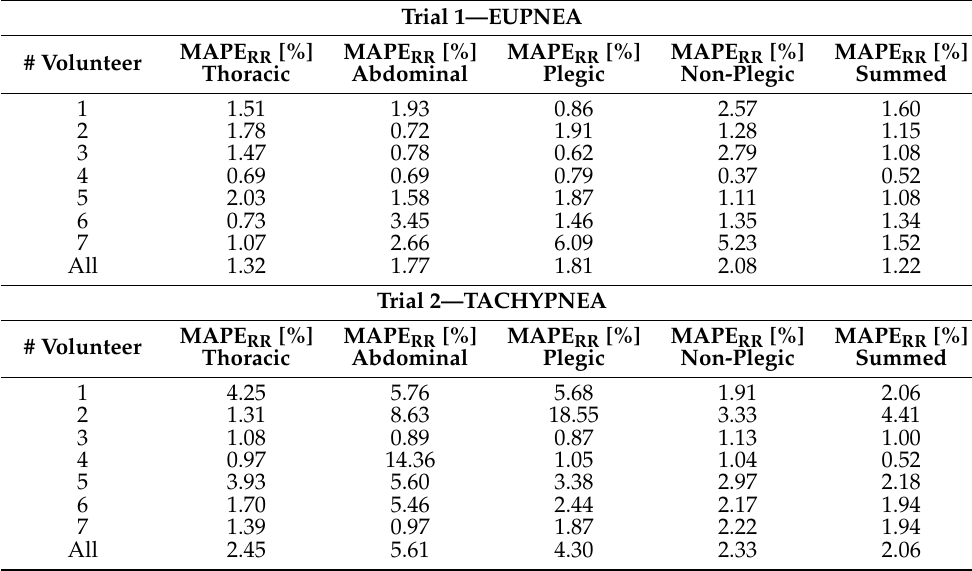
Table 2. MAPE RR [%] values reported for every volunteer in eupnea (Trial 1) and tachypnea (Trial 2). Trial